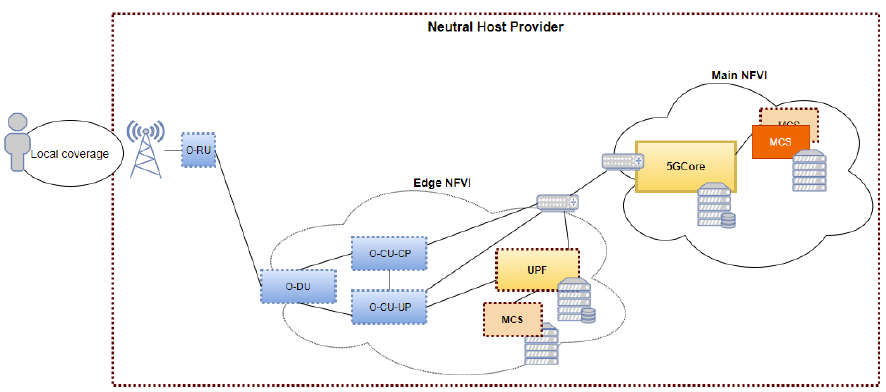
Figure 7. First deployment scenario of the emergency communication critical system.